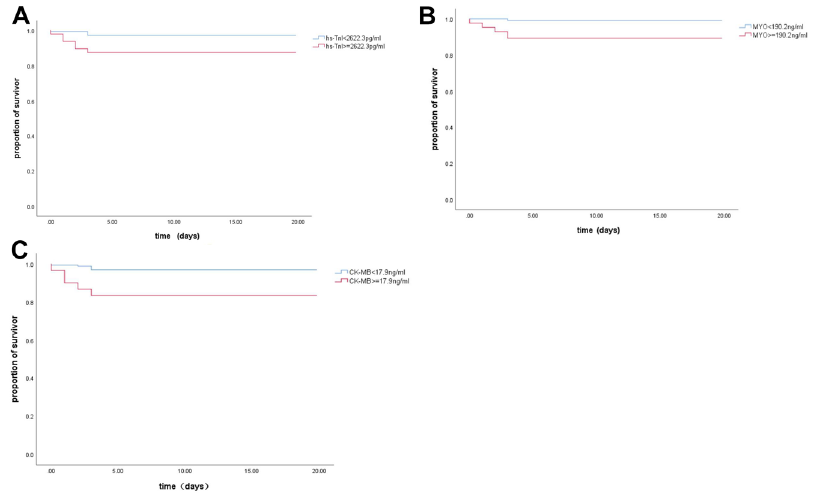
Table  : Independent predictors of major adverse cardiovascular event after CABG. Male vs. female